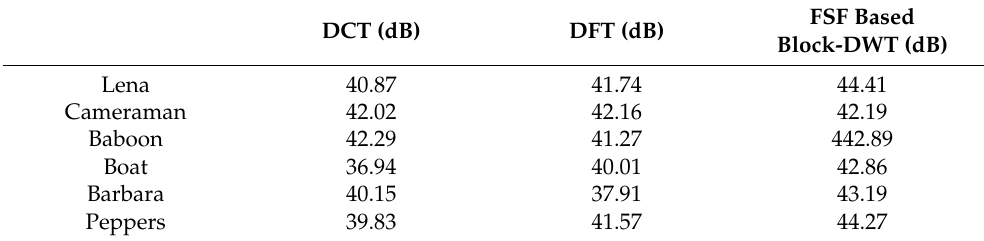
Table 2. Peak signal to noise ratio (PSNR) values for DCT, DFT and FSF-based Block-DWT